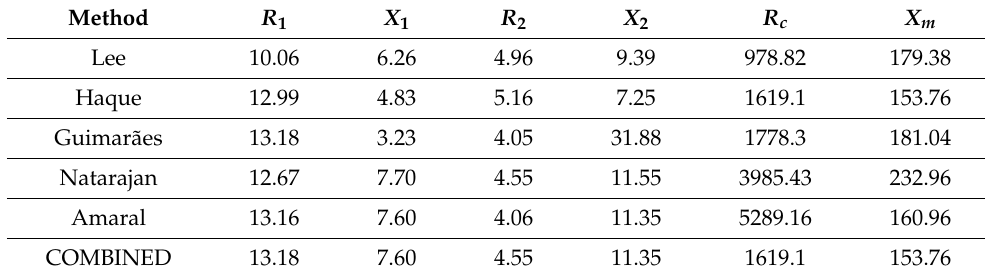
Table 2. Steady-state